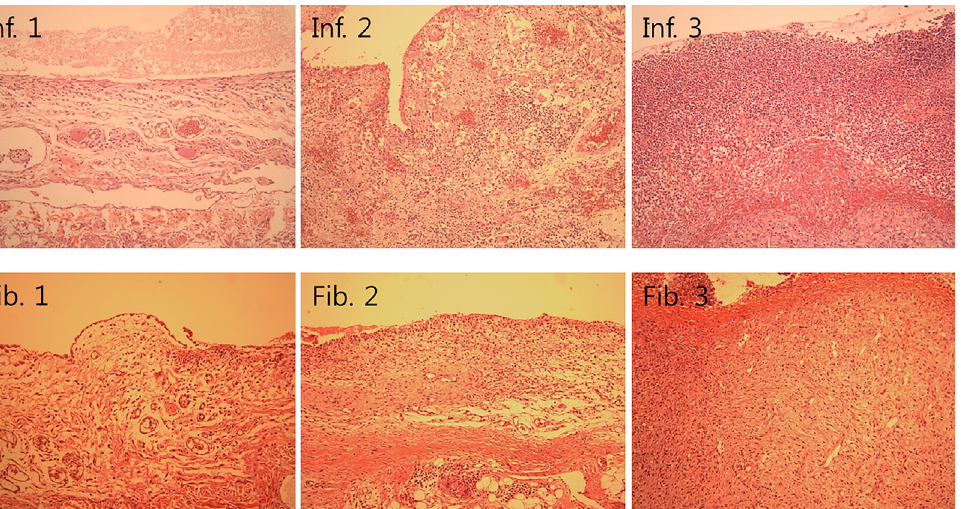
Fig 3. Histologic examination of inflammation and fibrosis (H&E stain, X 200). (Inf. 1) Inflammation grade 1: mild lymphocytic infiltration with several foreign body giant cells; (Inf. 2) Inflammation grade 2: moderate infiltration of neutrophils, eosinophils, and foreign body giant cells; (Inf. 3) Inflammation grade 3: marked neutrophil infiltration (abscess) along the pericardial surface. (Fib. 1) Fibrosis grade 1: loose fibrosis beneath the pericardial surface; (Fib. 2) Fibrosis grade 2: moderate fibrosis beneath the pericardial surface; (Fib. 3) Fibrosis grade 3: marked fibrosis beneath heavy leukocytic infiltration.